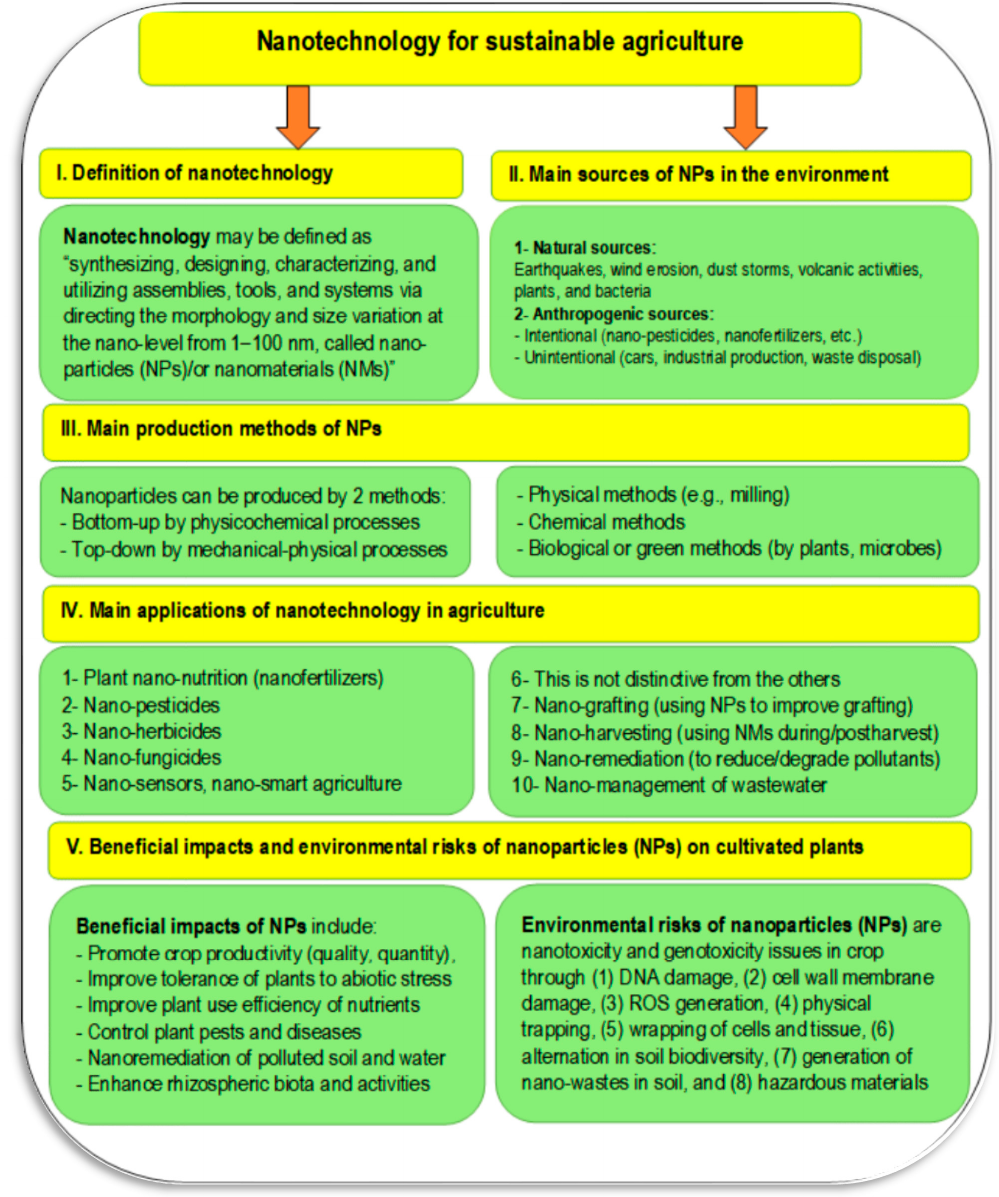
Figure 11. The relationship between nanotechnology and sustainable agriculture including differ- ent applications, methods of nano-production, and their benefits and challenges in agricultural application (Sources: